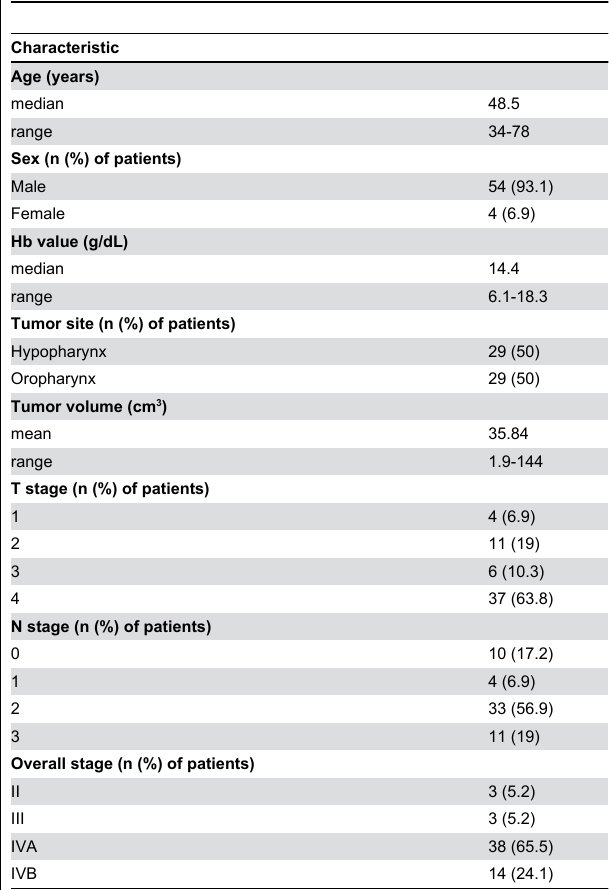
Table 1. Baseline characteristics of OHSCC patients (n =